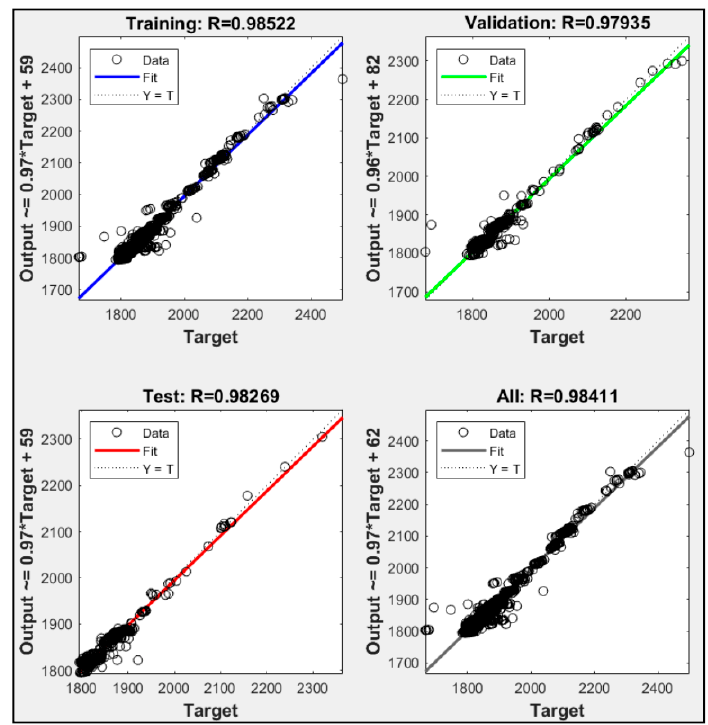
Figure 12. Regression result of P2 + P3.